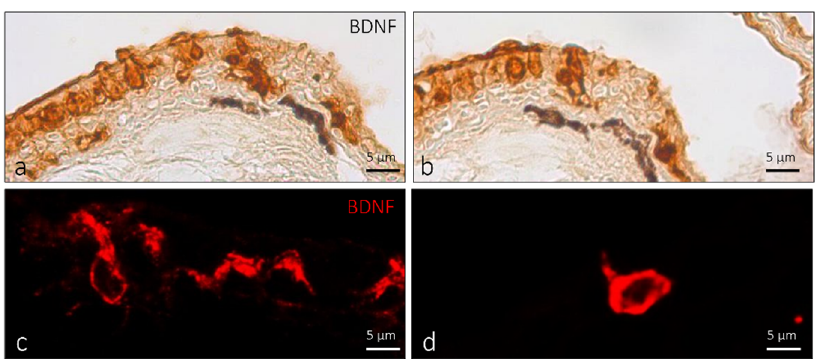
Figure 8. ICCC of adult zebrafish, dorsal view. Immunohistochemical detection of BDNF: ( a , b ) peroxidase method; ( c , d ) immunofluorescence method. ( a – d ) ICCC immunoreactivity to BDNF. Scale bar, 5 µm.